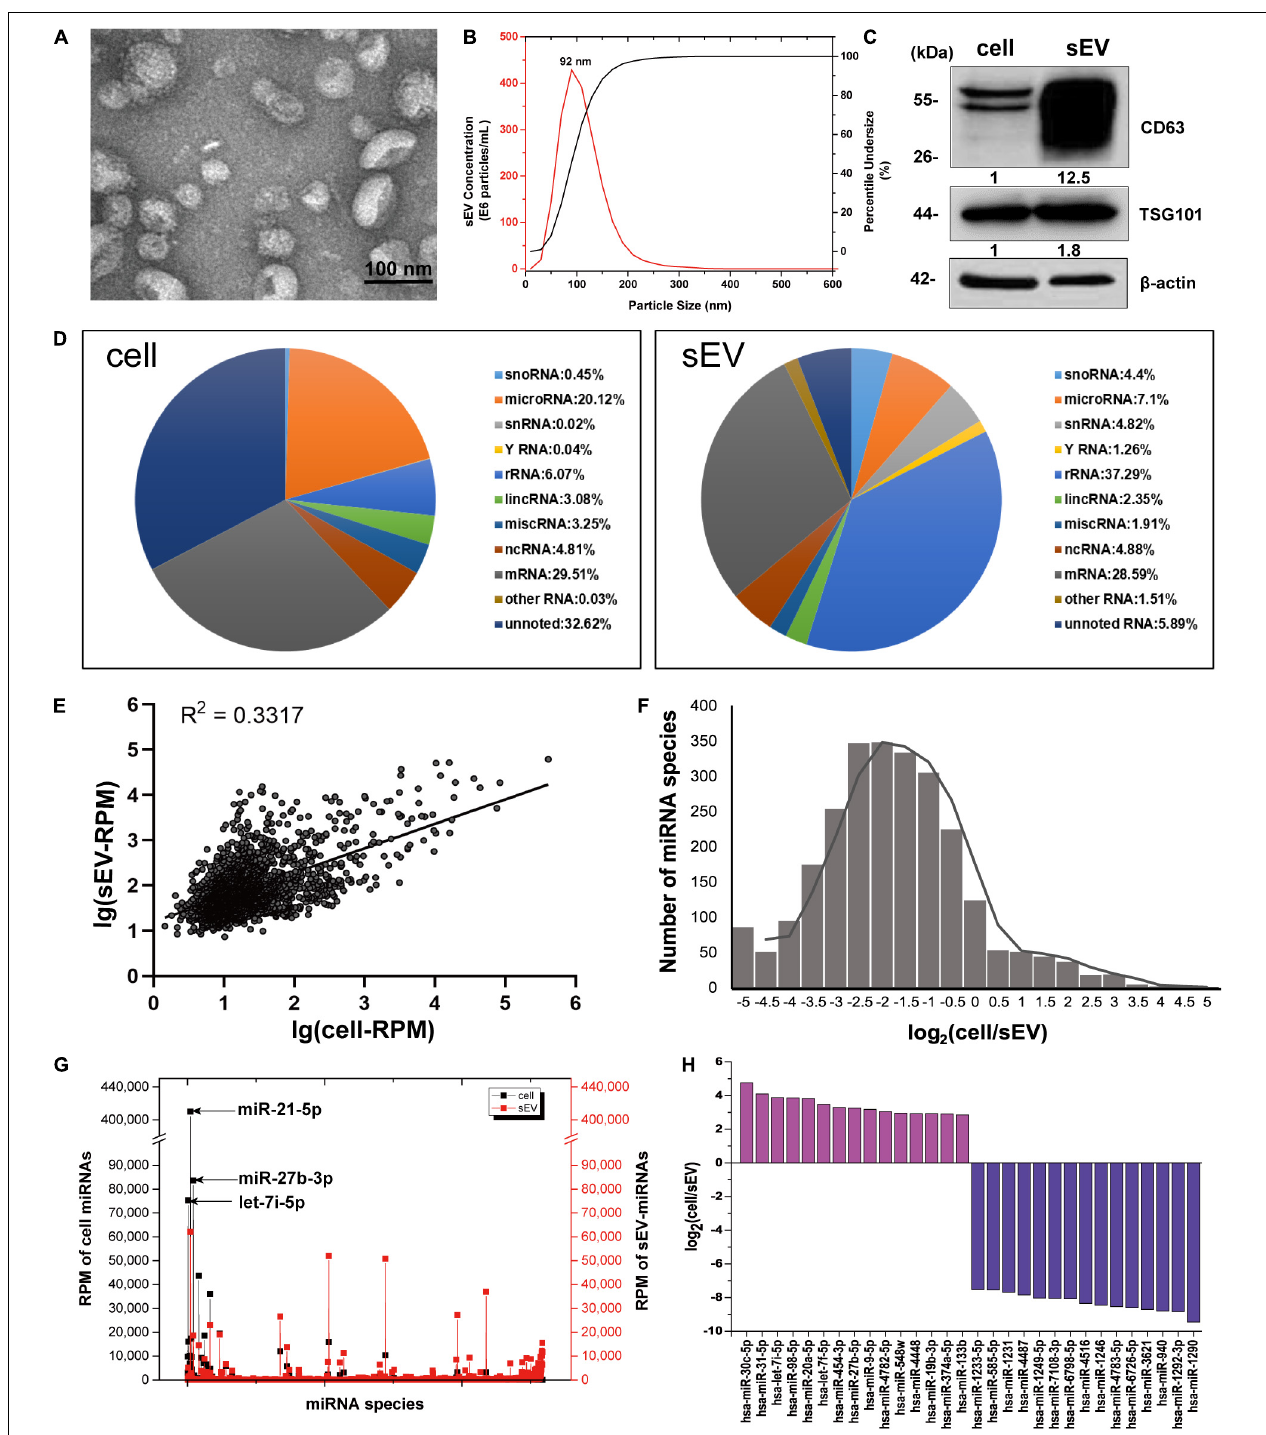
FIGURE 1 | The distribution features of miRNAs in cells and sEVs. (A) TEM image of isolated sEV pellets. Scale bar = 100 nm. (B) Size distribution of sEV pellets measured by NanoSight NS300 with the peak at 92 nm. (C) Western blotting analysis of sEV marker proteins CD63 and TSG101. (D) Pie charts showing the small RNA components and percentages of cells (left) and sEVs (right) based on small RNA sequencing data. (E) Scatter diagram showing the expressions of miRNAs in cells and sEVs. R square of linear-regression analysis is 0.3317. (F) Frequency histogram showing the miRNA species enriched in sEVs (x < 0) and cells (x > 0). (G) RPM of miRNAs in cells and sEVs. Black line: RPM of intracellular miRNAs. Red line: RPM of sEV-miRNAs. (H) Histogram showing the enrichment multiple of the top 15 enriched miRNAs in cells (y > 0) and sEVs (y < 0). miRNAs, microRNAs; TEM, transmission electron microscopy; sEVs, small extracellular vesicles; RPM, reads per